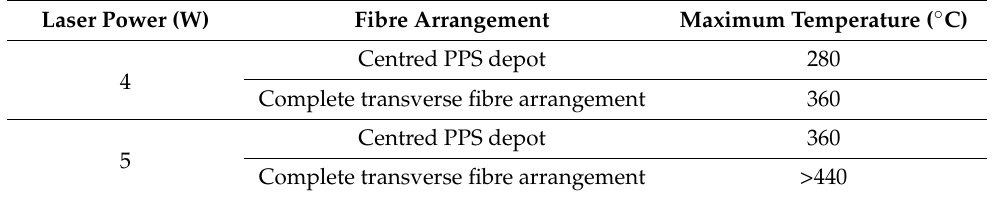
Table 2. Temperature profiles of CFRP with fibre